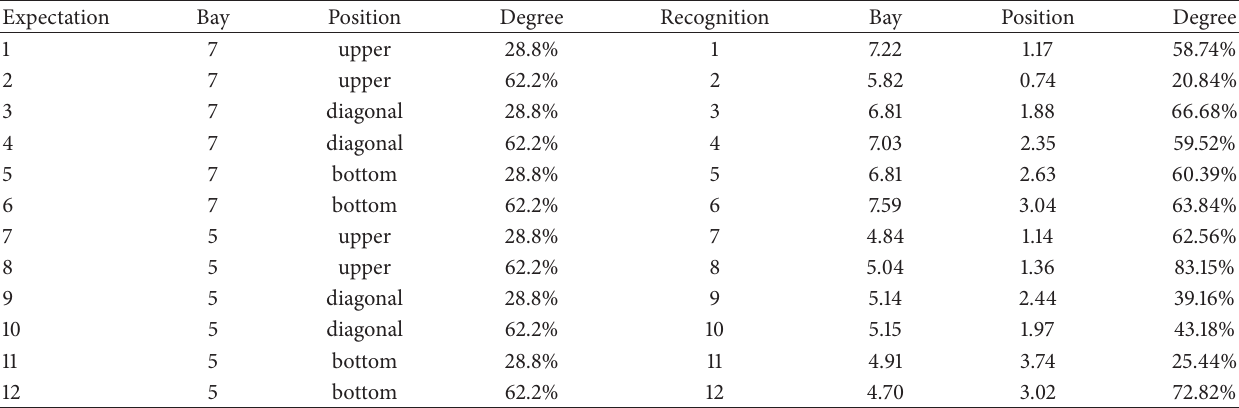
Table 15: Damage identification by using attribute set 3.